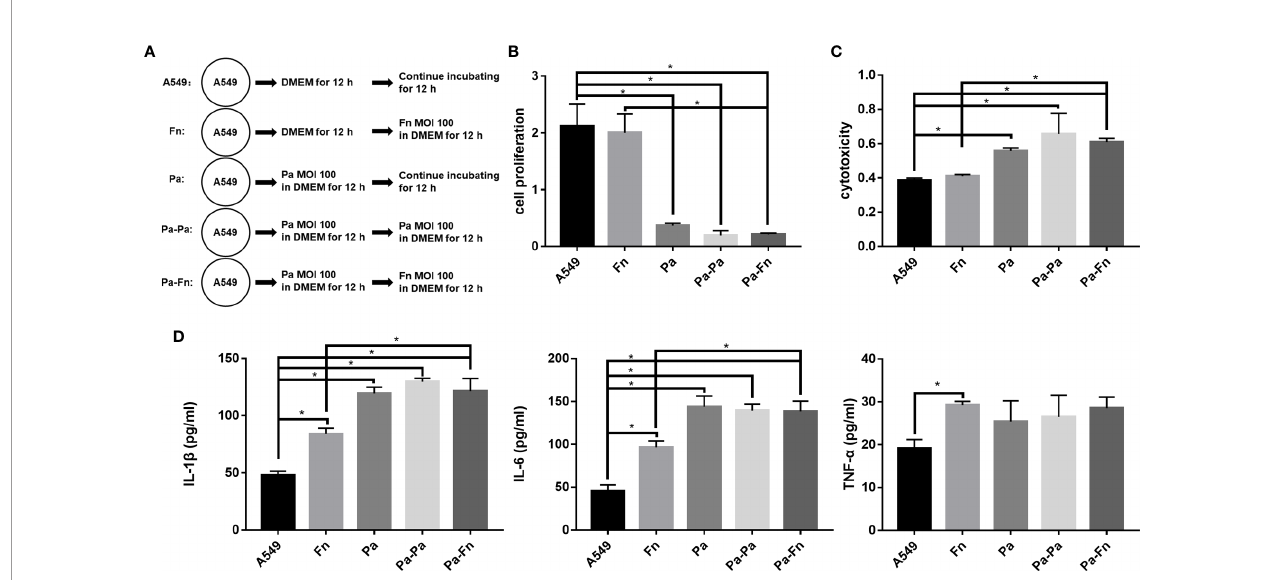
FIGURE 5 | The effect of F. nucleatum subsequential infection on cellular proliferation, cytotoxicity and in fl ammation. (A) Schematic representation of cell assay. A549 cells cultured in DMEM for 24 h were the blank control. Fn represented A549 cells precultured in DMEM for 12 h followed by F. nucleatum (MOI 100) infection for other 12 h. Pa represented A549 cells treated with P. aeruginosa (MOI 100) for 24 h. Pa-Pa means that A549 cells pretreated with P. aeruginosa (MOI 100) for 12 h continue to be infected with another P. aeruginosa (MOI 100) for 12 h. Pa-Fn means that A549 cells pretreated with P. aeruginosa (MOI 100) for 12 h continue to be infected with F. nucleatum (MOI 100) for 12 h. (B) The effect of F. nucleatum subsequential infection on cellular proliferation of pulmonary epithelial cells. (C) The effect of F. nucleatum subsequential infection on cytotoxicity of pulmonary epithelial cells. (D) The effect of F. nucleatum subsequential infection on IL-1 b , IL-6 and TNF- a productions of pulmonary epithelial cells. * P < 0.05, statistics were achieved by analysis of variance followed by Sidak ’ s multiple comparisons